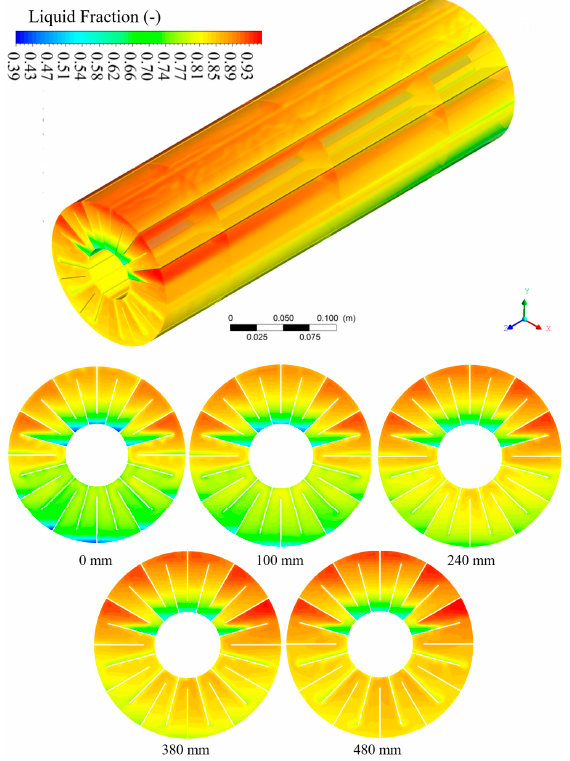
Figure 15. PCM liquid fraction distribution for 80% of volume in a liquid state (t = 5272 s).